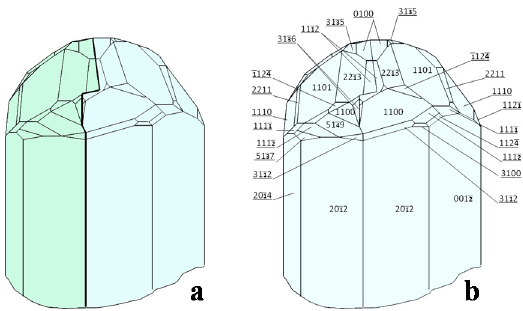
Figure 5. Morphology of calaverite. ( a ) Calaverite twinned crystals; ( b ) Indexed morphology of calaverite according to Janner and Dam [45]. Modified and redrawn from Chapuis [46].